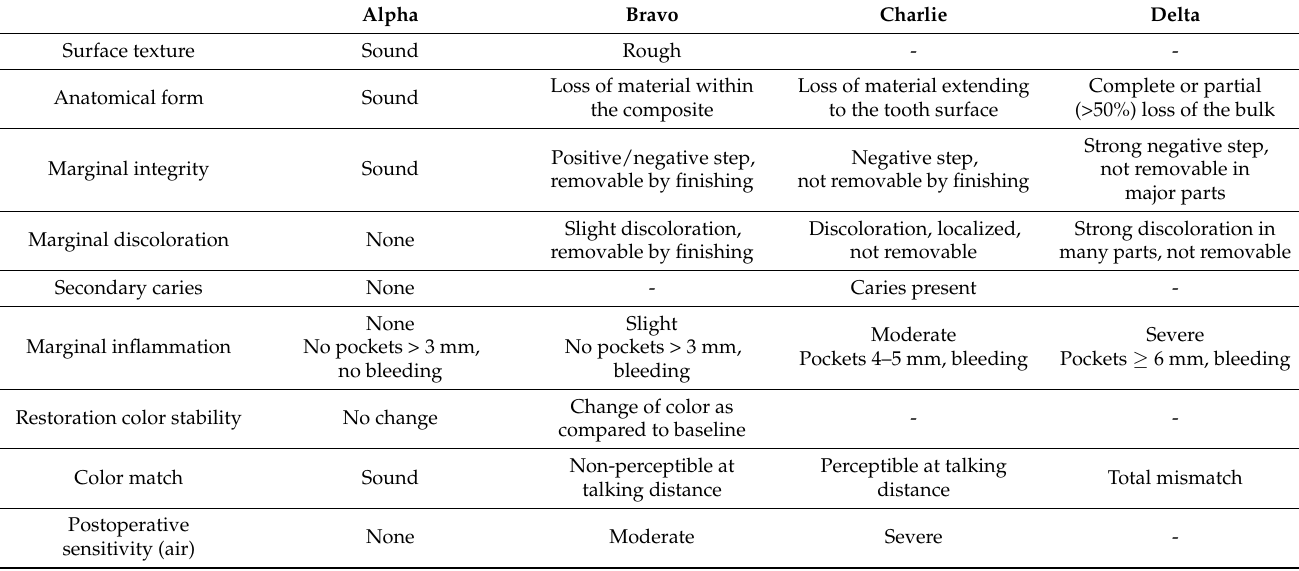
Table 3. Modified United States Public Health Service (USPHS) criteria applied for the clinical evaluation of the